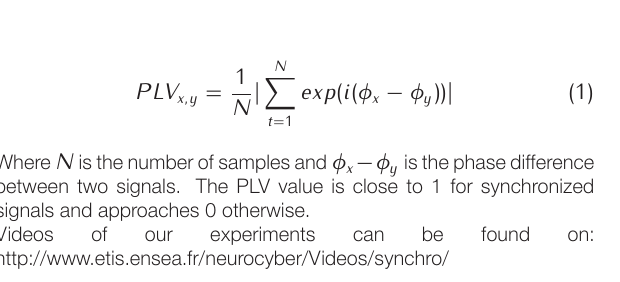
Where N is the number of samples and ϕ x − ϕ y is the phase di(cid:636)erence between two signals. The PLV value is close to 1 for synchronized signals and approaches 0 otherwise. Videos of our experiments can be found on: